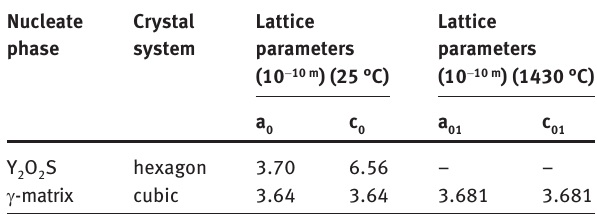
Table 2: Crystallographic data of Y 2 O 2 S and γ -matrix Nucleate phase